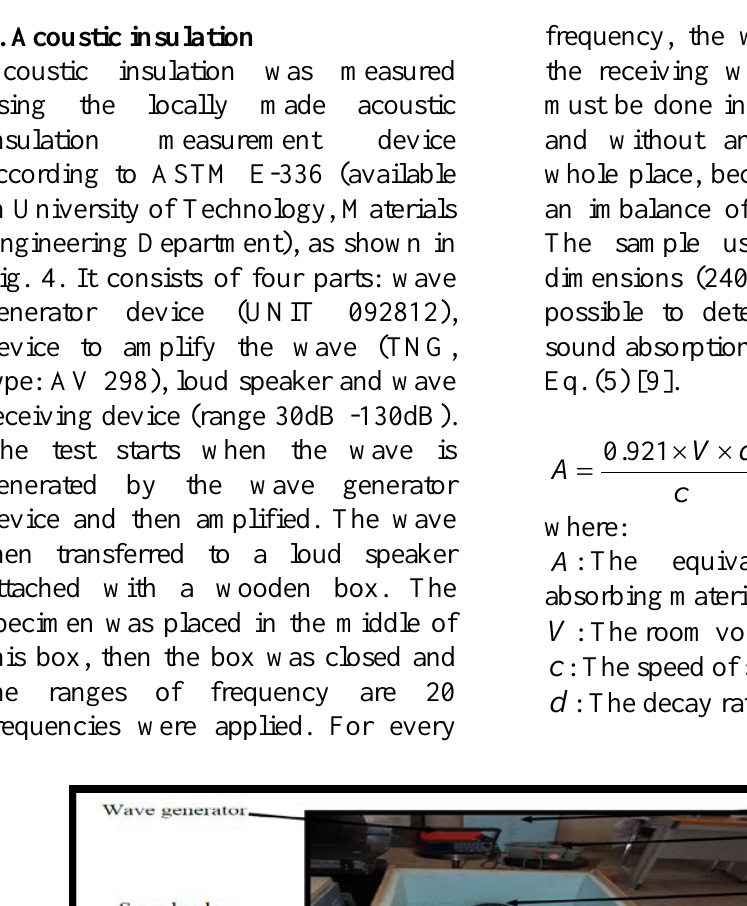
Fig.3: Thermal conductivity samples.